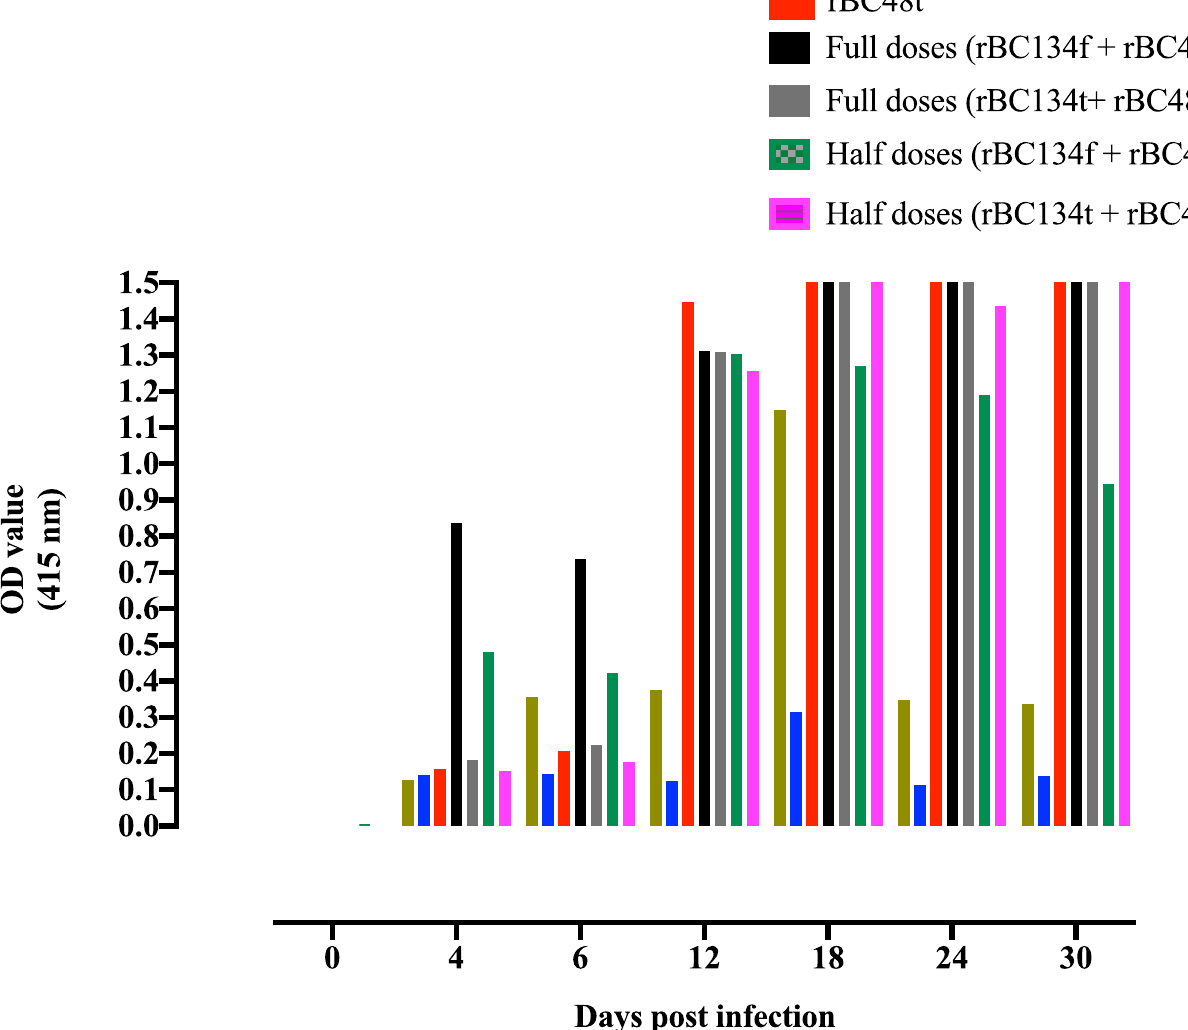
Fig 2. Reactivity of ELISA using recombinant proteins with serially collected sera from a horse experimentally infected with B . caballi .